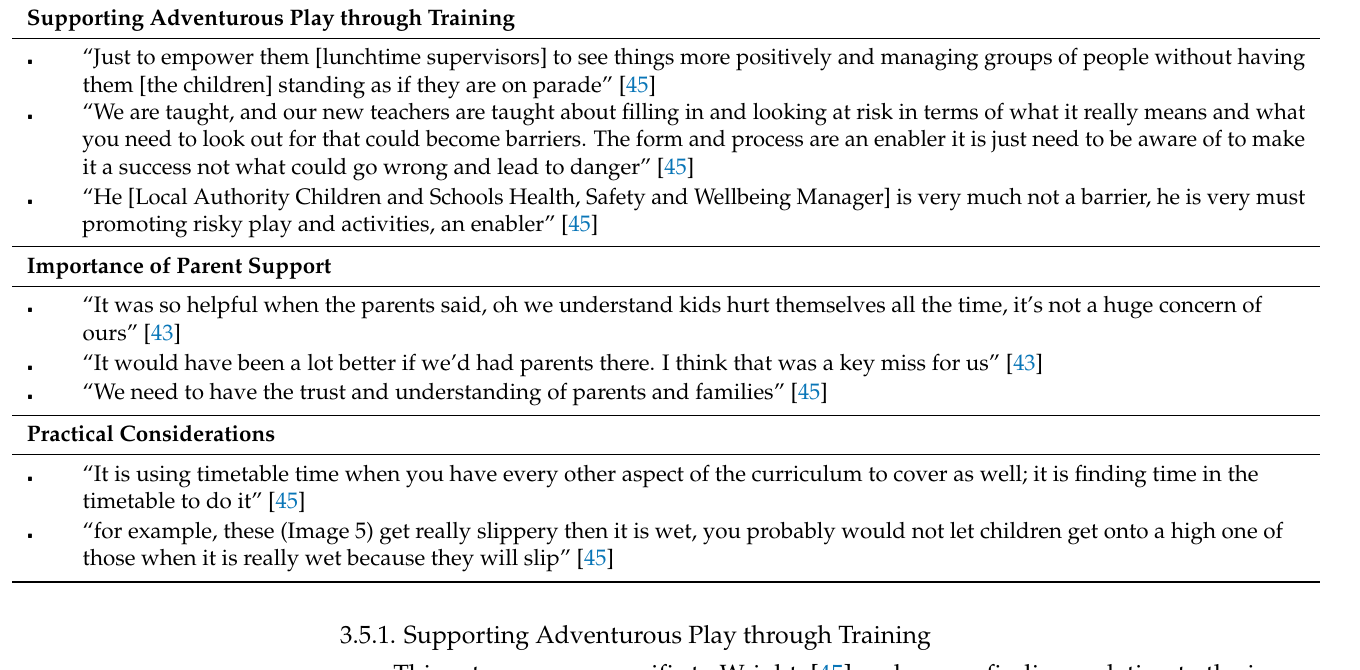
Table 6. Synthesised finding 4: School environment and